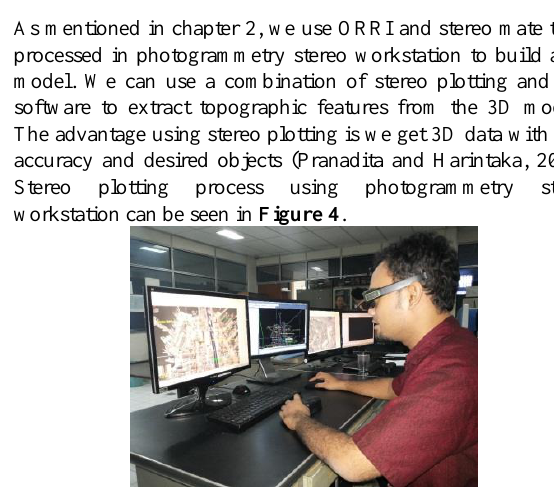
Figure 4. Stereo plotting process (picture taken from Center of Topographic Mapping and Toponym